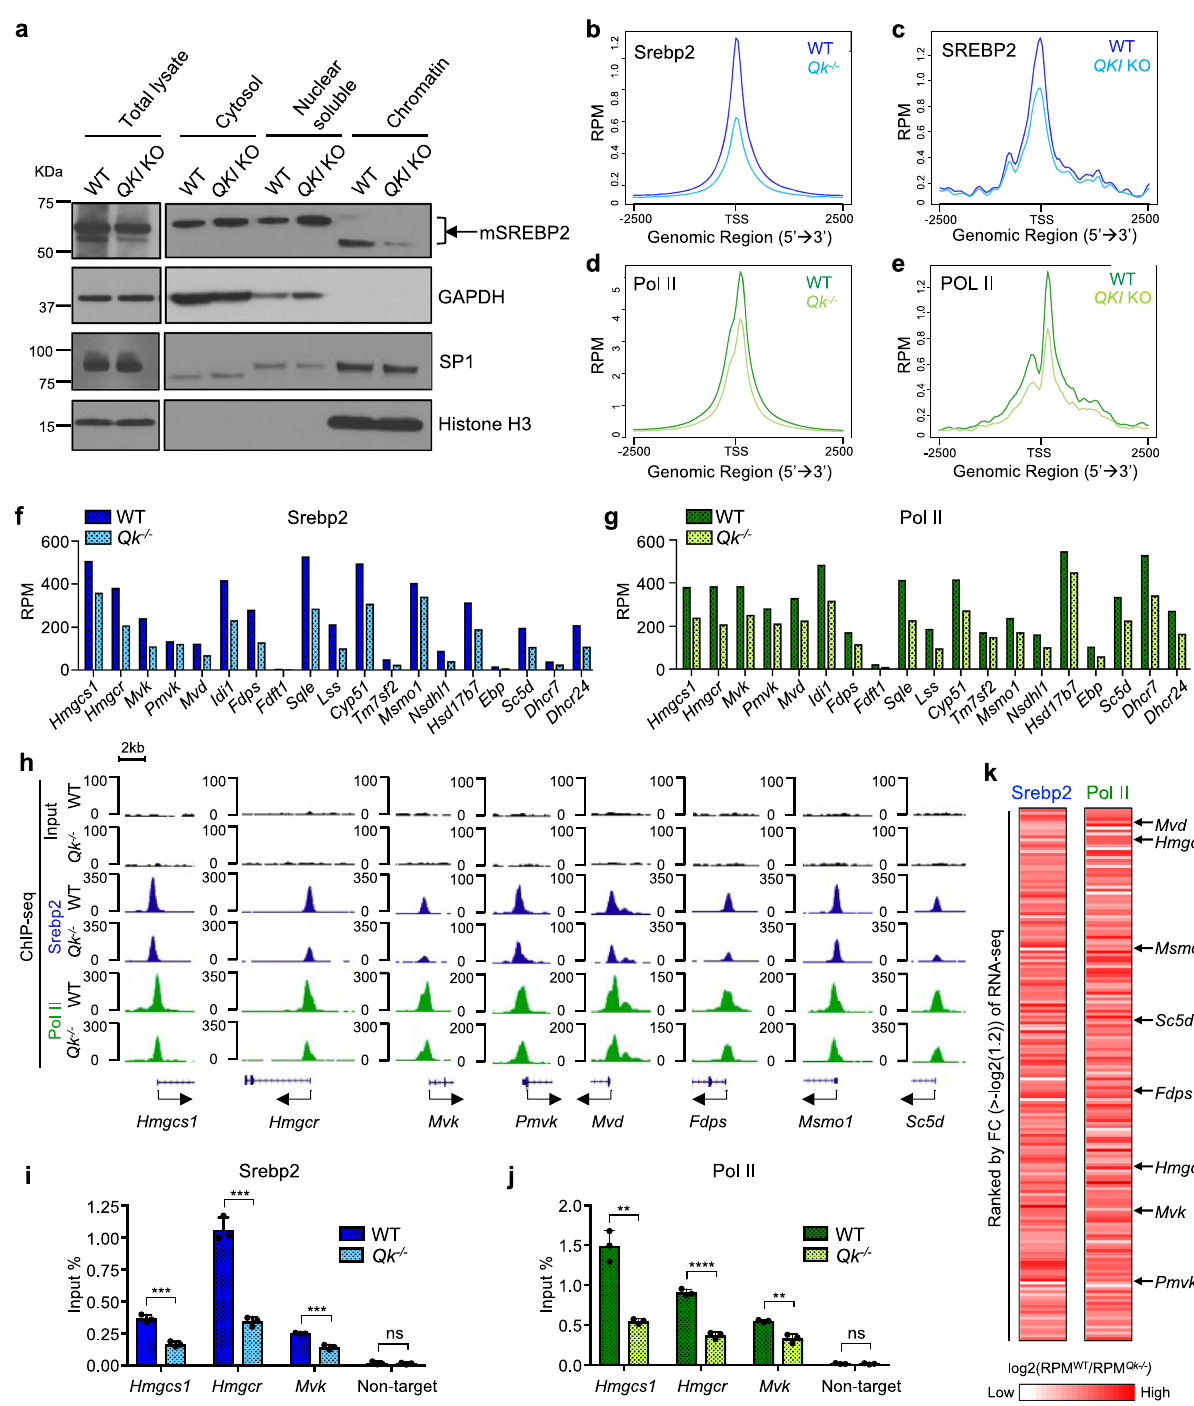
Fig. 6 QKI-5 transcriptionally enhances cholesterol biosynthesis by facilitating SREBP2/POL II recruitment. a Immunoblots for detection of mSREBP2 (mature SREBP2) in subcellular fractions of HLE-B3 cells. GAPDH: cytosol; SP1: nuclei; Histone H3: chromatin. The result was repeated three times. b , c Signalplots showing RPM for SREBP2 in b NLPCs and c HLE-B3 cells ±2.5 kb from the TSS of SREBP2-bound peaks in WT and QKI KO cells. d , e Signalplots showing the read counts per million mapped reads for POL II in d NLPCs and e HLE-B3 cells ±2.5 kb from the TSS of SREBP2-bound peaks in WT and QKI KO cells. f , g RPM value of all the 19 cholesterol biosynthesis genes in f Srebp2 ChIP-seq and g Pol II ChIP-seq in WT and Qk -/- NLPCs. h Representative UCSC Genome Browser snapshot of the promoter regions of cholesterol biosynthesis genes from ChIP-seq of NLPCs. i , j Srebp2 and Pol II ChIP-qPCR analysis of the promoter regions of Hmgcs1 , Hmgcr , and Mvk in WT and Qk -/- NLPCs. i p = 0.0006554 ( Hmgcs1 ); 0.0002616 ( Hmgcr ); 0.0005623 ( Mvk ); 0.7637 (Non-target). j p = 0.001092 ( Hmgcs1 ); 0.00009184 ( Hmgcr ); 0.002848 ( Mvk ); 0.7947 (Non-target). ** p < 0.01; *** p < 0.001; **** p < 0.0001; ns not signi fi cant ( p ≥ 0.05) (two-tailed unpaired t -test). The results are presented as means with SD. Data are representative of three independent experiments. k Heatmap of normalized fold change of RPM in WT NLPCs over Qk -/- NLPCs (log2(RPM WT /RPM Qk-/- ) in Srebp2 and Pol II ChIP-seq data ranked by fold change in RNA-seq of NLPCs. Arrows indicate cholesterol biosynthesis genes.